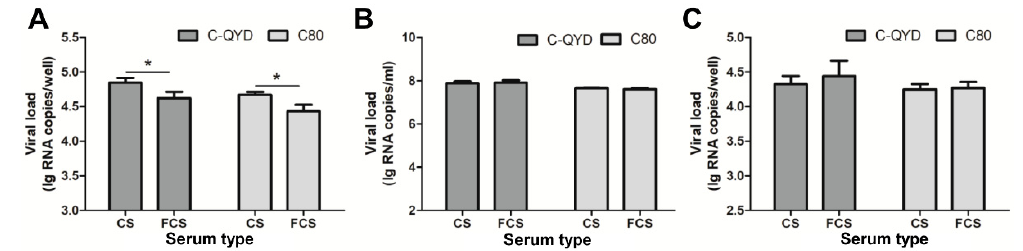
Figure 5. Investigation into the e ff ect of FCS on virus adsorption and penetration. ( A ) Virus attachment inhibition assay. The FCS–virus mixture was used as inoculum. After adsorption at 4 ◦ C for 1 h, the cells were washed to remove unbound virus, and the amount of bound virus was quantified. ( B ) DEF cells were pretreated with 2% FCS DMEM at 37 ◦ C for 1 h, followed by inoculation with virus. Viral loads in cells + supernatant were detected at 18 hpi. ( C ) Analysis of e ff ect of FCS on virus entry. Virus adsorption was carried out at 4 ◦ C, followed by incubation of the cells with FCS at 37 ◦ C for 1 h. Proteinase K was employed to remove extracellular viruses and inactivated with PMSF. Intracellular viruses were quantified. In each test, CS served as a control. Error bars represent the SD ( n = 3); * p < 0.05.